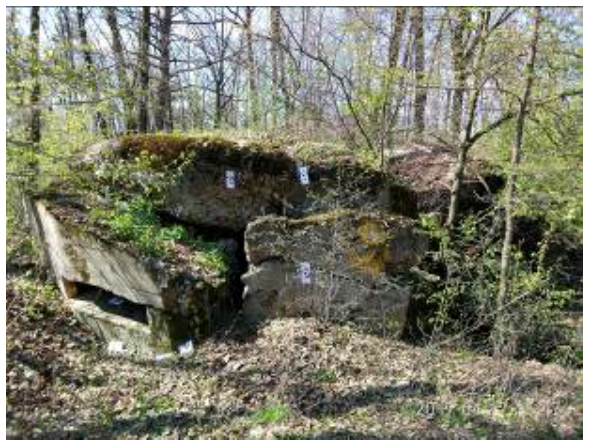
Figure 8. Image of pillbox № 451 with coded targets